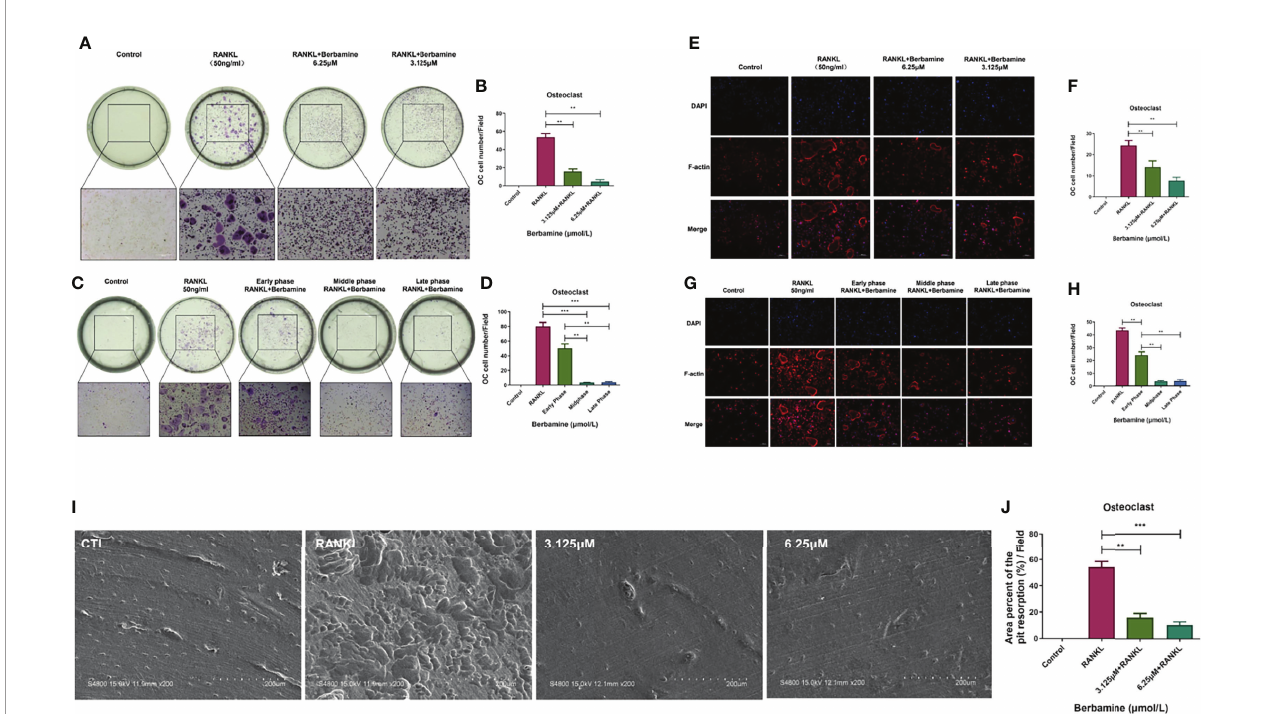
FIGURE 2 | Berbamine can mainly inhibit RANKL-induced osteoclastogenesis of BMMs in vitro in the middle and late phases. (A) The results of TRAP staining revealed that berbamine (3.125 and 6.25 m M) could inhibit RANKL-induced osteoclastogenesis of BMMs in vitro . (B) The numbers of mature, polynuclear osteoclasts were reduced signi fi cantly in a dose-dependent manner after treatment with berbamine. (C) The results of TRAP staining revealed that berbamine inhibited osteoclastogenesis of BMMs mainly in the middle and late phases, not in the early phase. (D) The numbers of mature, polynuclear osteoclasts were reduced signi fi cantly when berbamine treatment was conducted in the middle phase or late phase of osteoclastogenesis. (E) Berbamine (3.125 and 6.25 m M) inhibited RANKL-induced podosome belt formation of BMMs in vitro . (F) The numbers of mature, polynuclear osteoclasts were reduced in a dose-dependent manner when BMMs were treated with berbamine. (G) Berbamine inhibited RANKL-induced podosome belt formation of BMMs mainly in the middle and late phases of osteoclastogenesis, not in the early phase. (H) The numbers of mature, polynuclear osteoclasts were reduced in a dose-dependent manner when BMMs were treated with berbamine. (I) Masses of bone resorption pits were observed on the surfaces of the bone slices in the RANKL group. (J) The percent area of pit resorption on the surfaces of bone slices was signi fi cantly higher in the RANKL group than in the berbamine treatment groups. The data are presented as the mean ± SD, **P < 0.01; ***P <